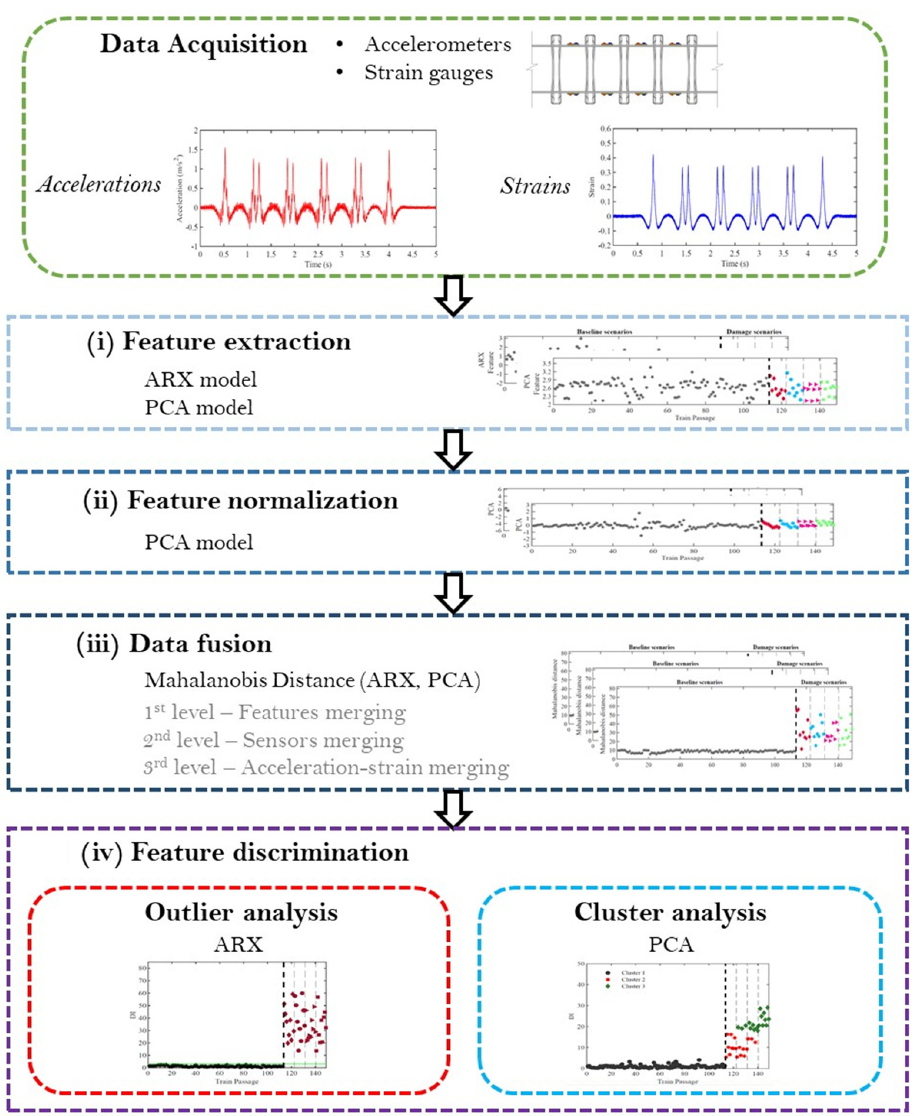
Figure 10. Methodology for the automatic identification of unbalanced loads.